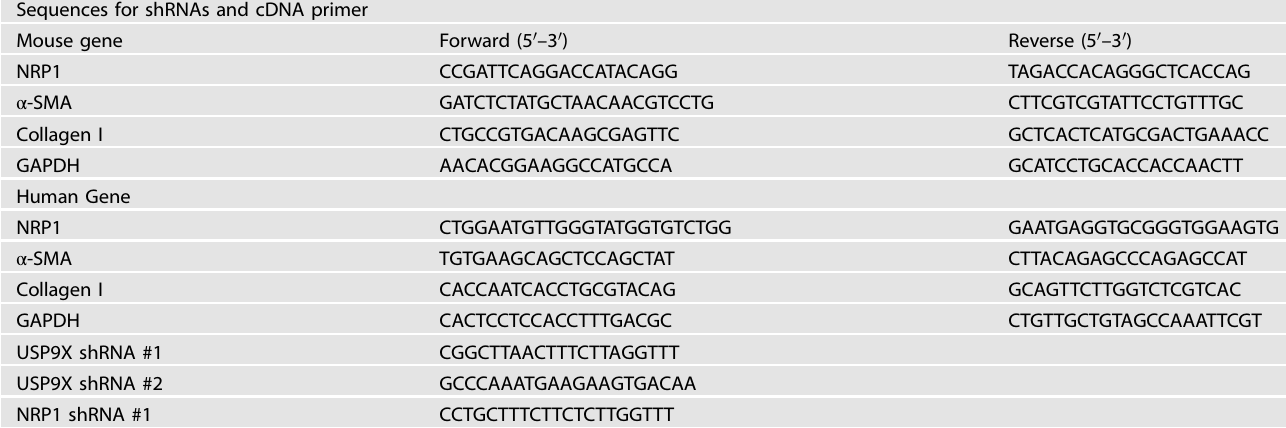
Table 1. Characterization of the sequences of cDNA primers and